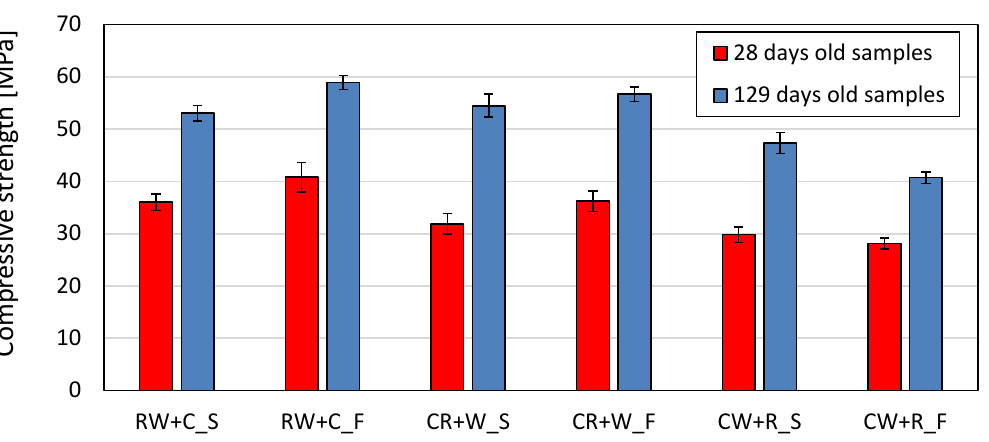
Figure 5. Compressive strength of the samples (with standard